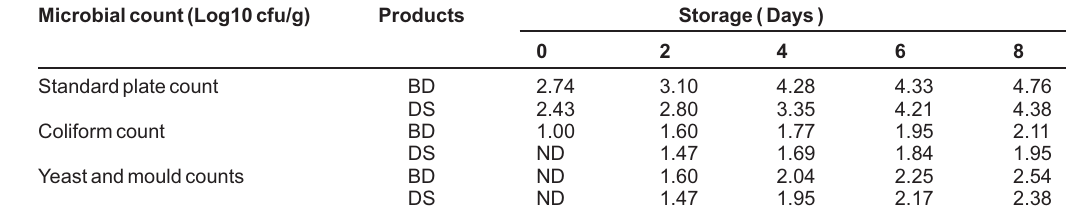
Table-2: Microbiological quality of masala paneer products during storage under refrigeration